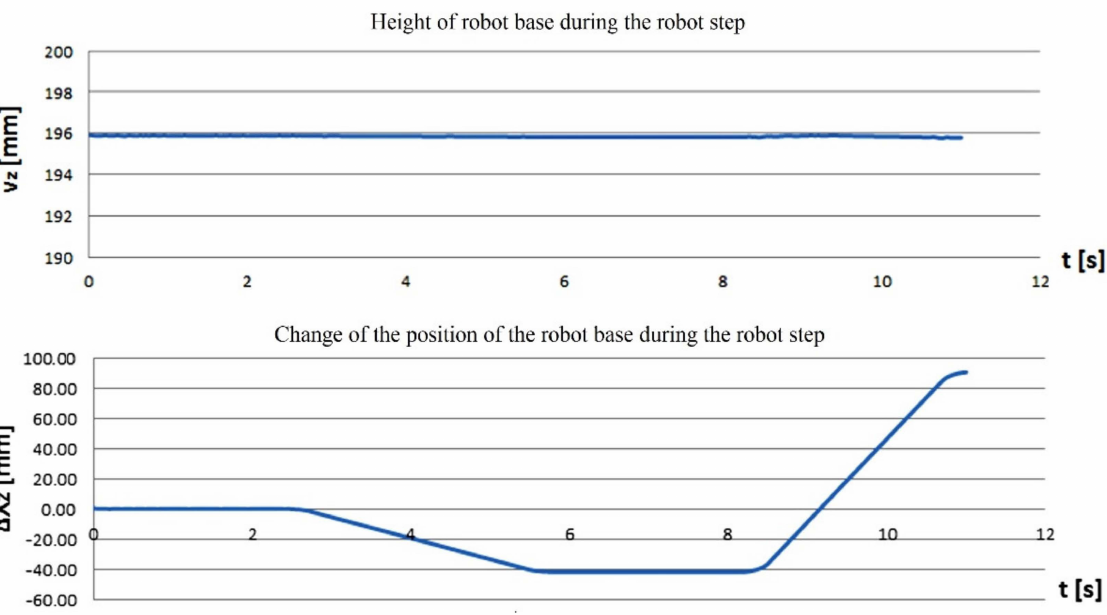
Figure 16. Changes in position of the robot’s base during the